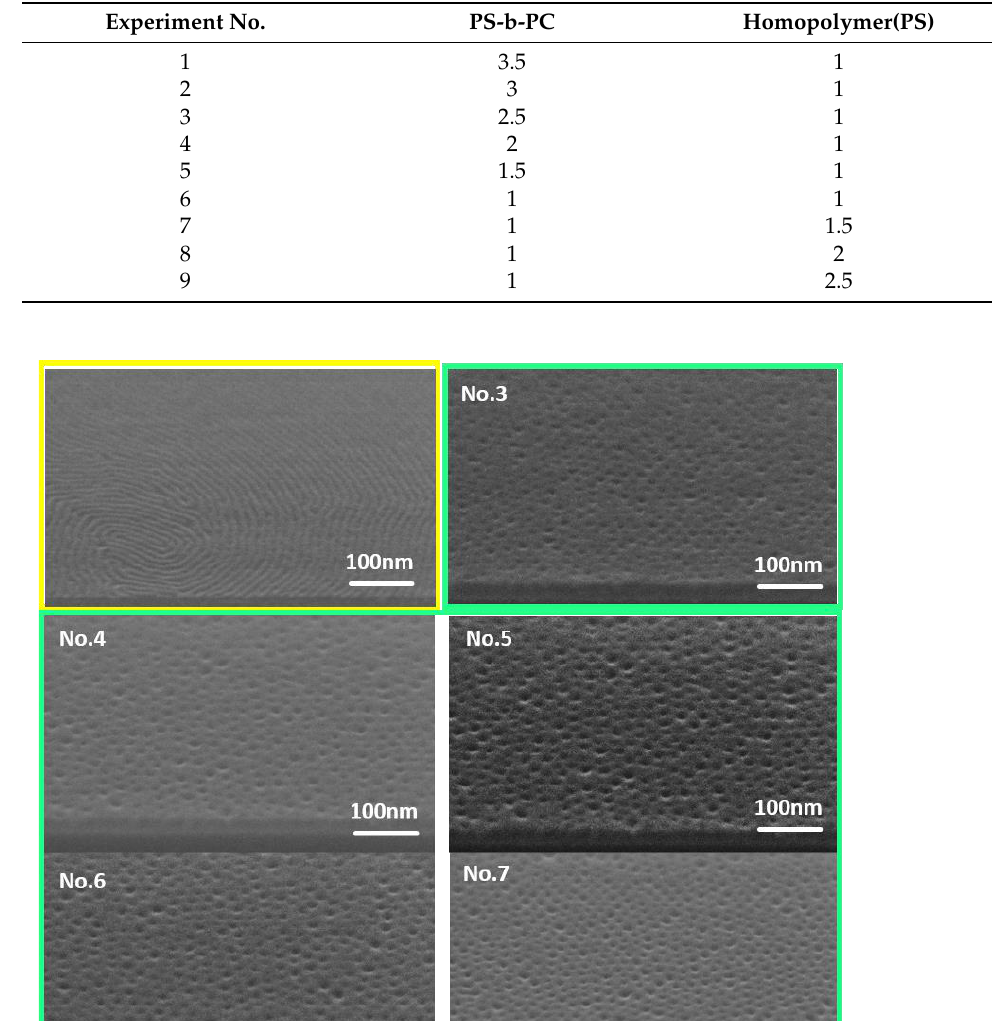
ments No. 3 to No.7, in which the cylinder diameters are 12.36 nm, 13.09 nm, 15.12 nm, 14.26 nm, and 11.85 nm, respectively. The red boxes are other structures formed by the phase separation of the blended materials, in which experiments No. 1 and No. 2 formed a mixed structure of layered and porous, and experiments No. 8 and No. 9 formed irreg- ular structures. When the proportion of PS is low, layered and porous structures are formed. With an increase in the PS ratio, the microdomain area of the layered structure decreases, and the microdomain area of the porous structure increases. When PS-b-PC:PS reaches 2.5:1,